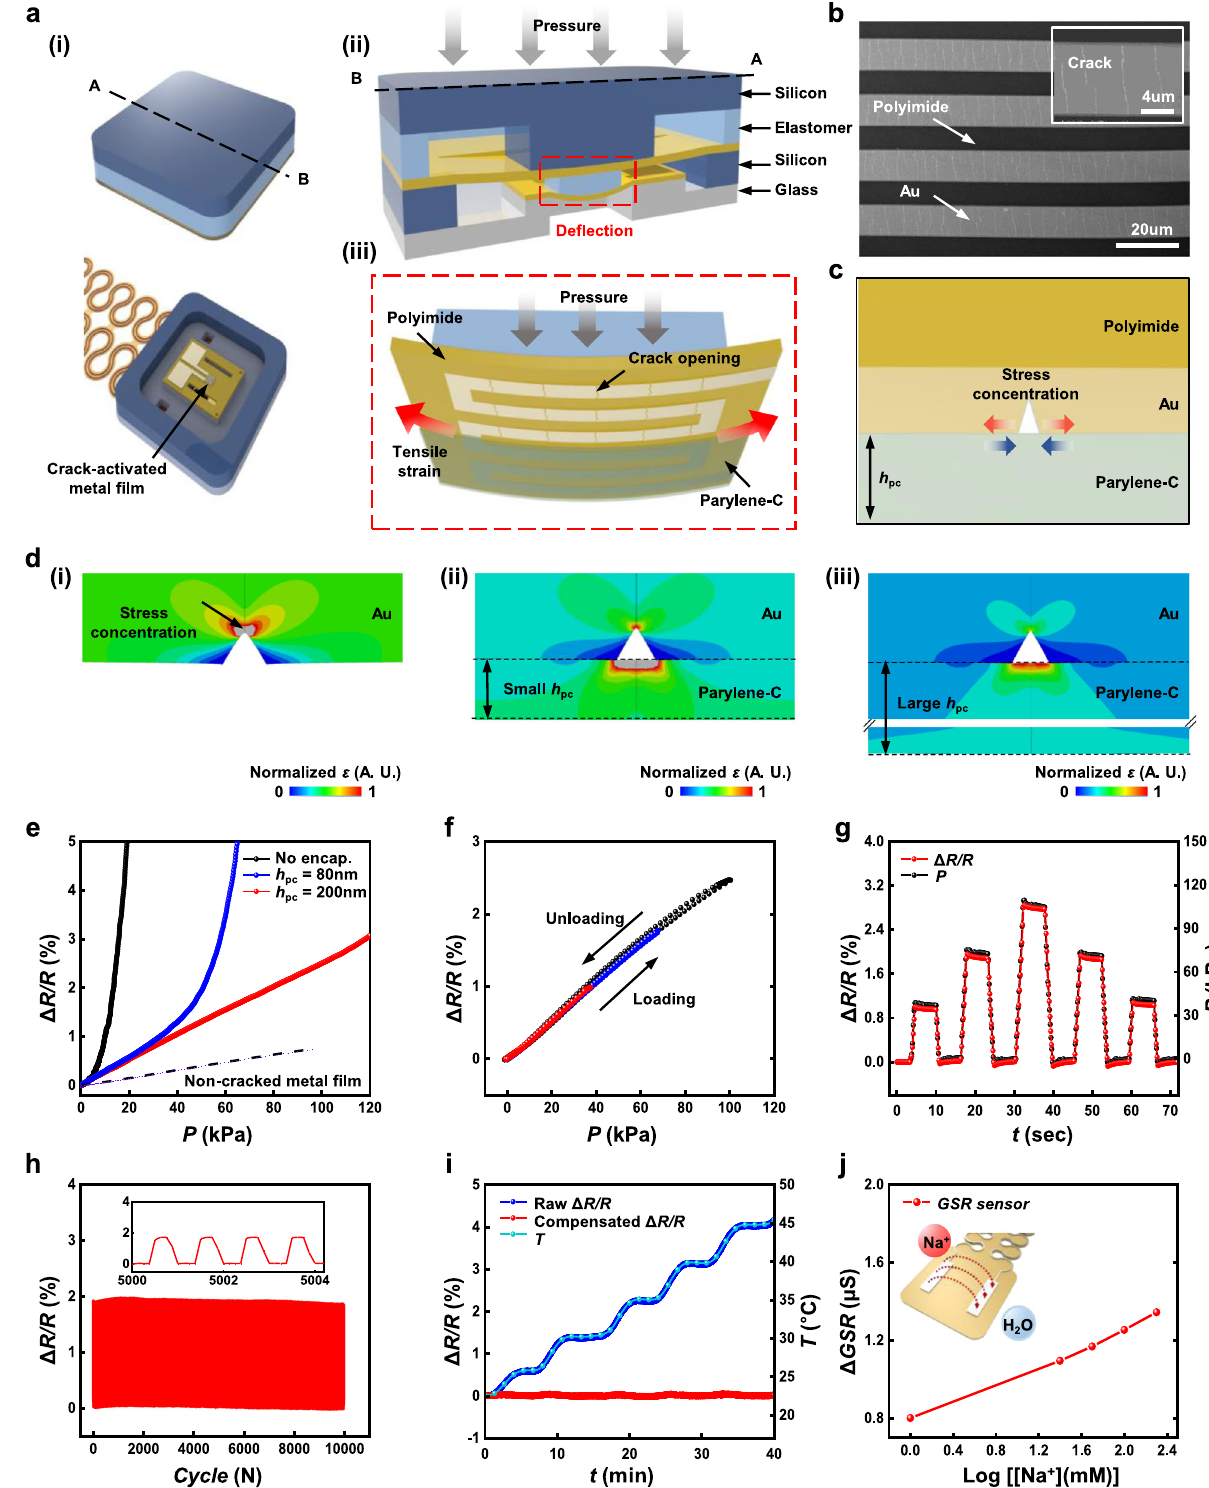
change. Supplementary Fig. 3 illustrates the structural design of the platform used to obtain reversible responses from fi nite element analysis (FEA) results for stretching and bending. These results indicate that the device ensures gentle placement on the curved skin without mechanical or electrical failure, even under change in posture.